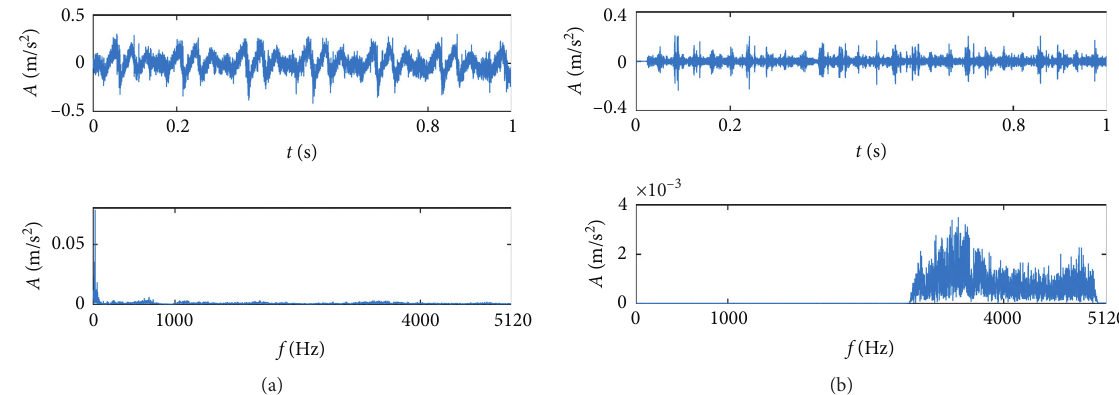
Figure 17: Experimental signal of the time domain and frequency domain under misfire fault. (a) Original signal. (b) Filtered signal.